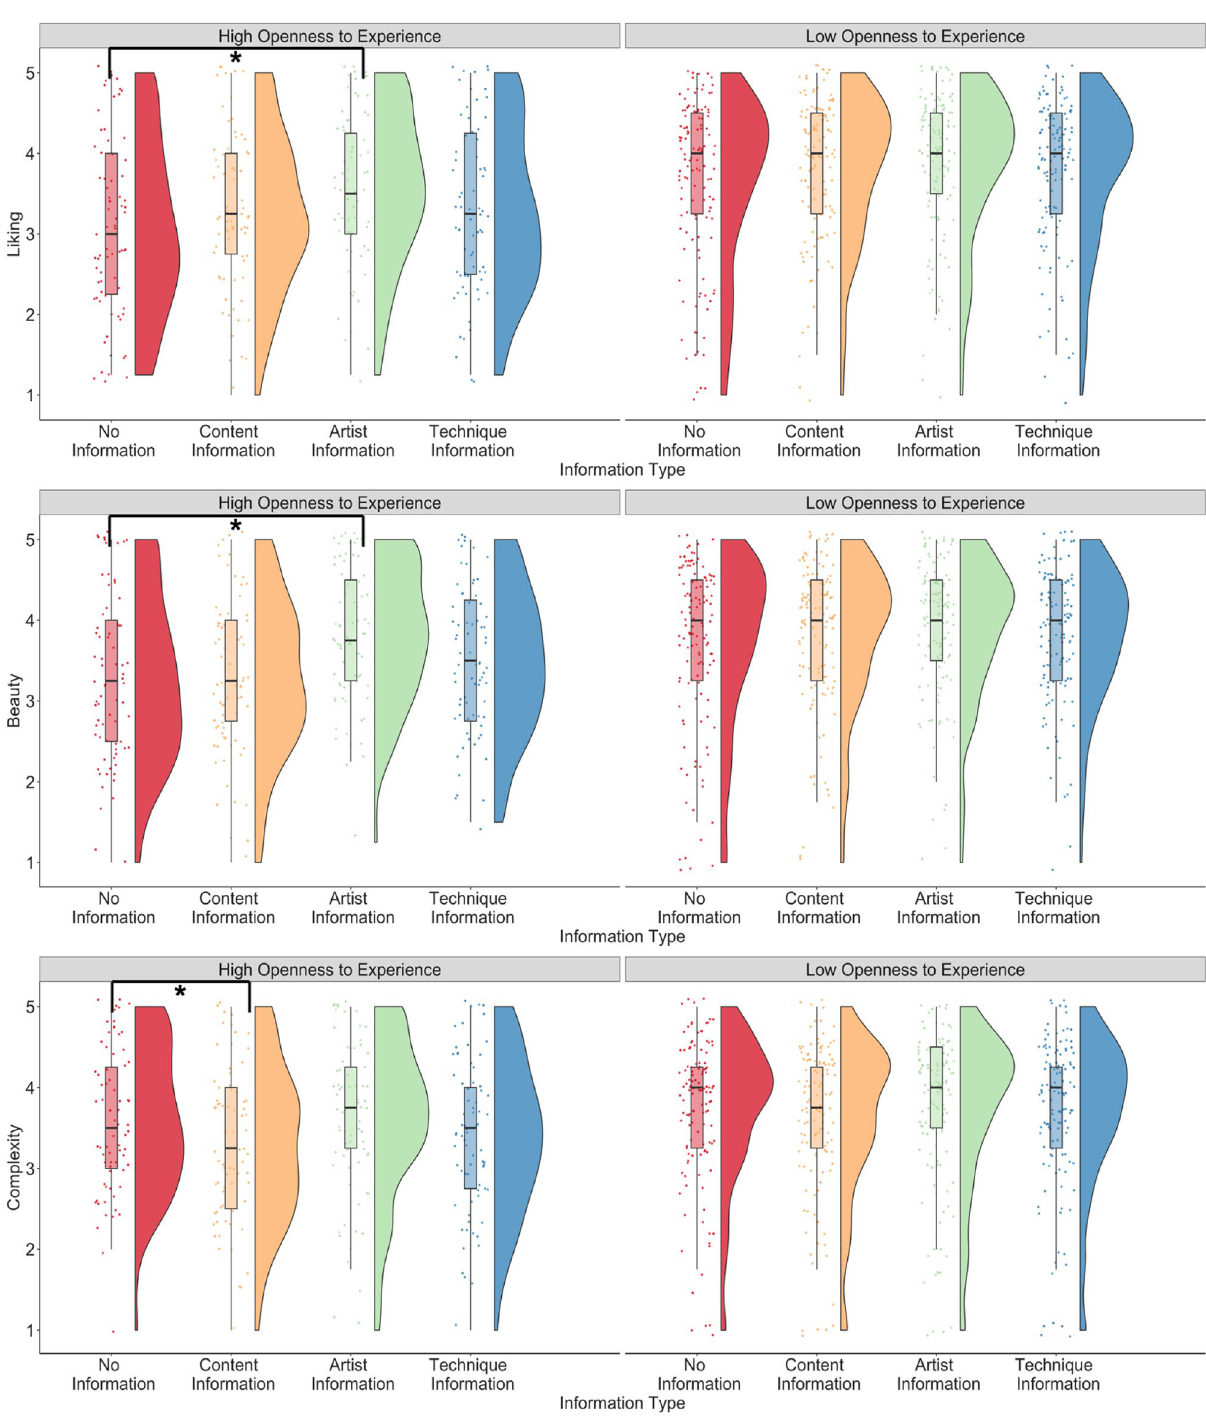
Figure 4. Liking, beauty, and complexity ratings when no contextual information was provided to participants, and when information about the artist, information about the content, and information about the technique was provided to participants, split by participants with high and low openness to experience. *p <